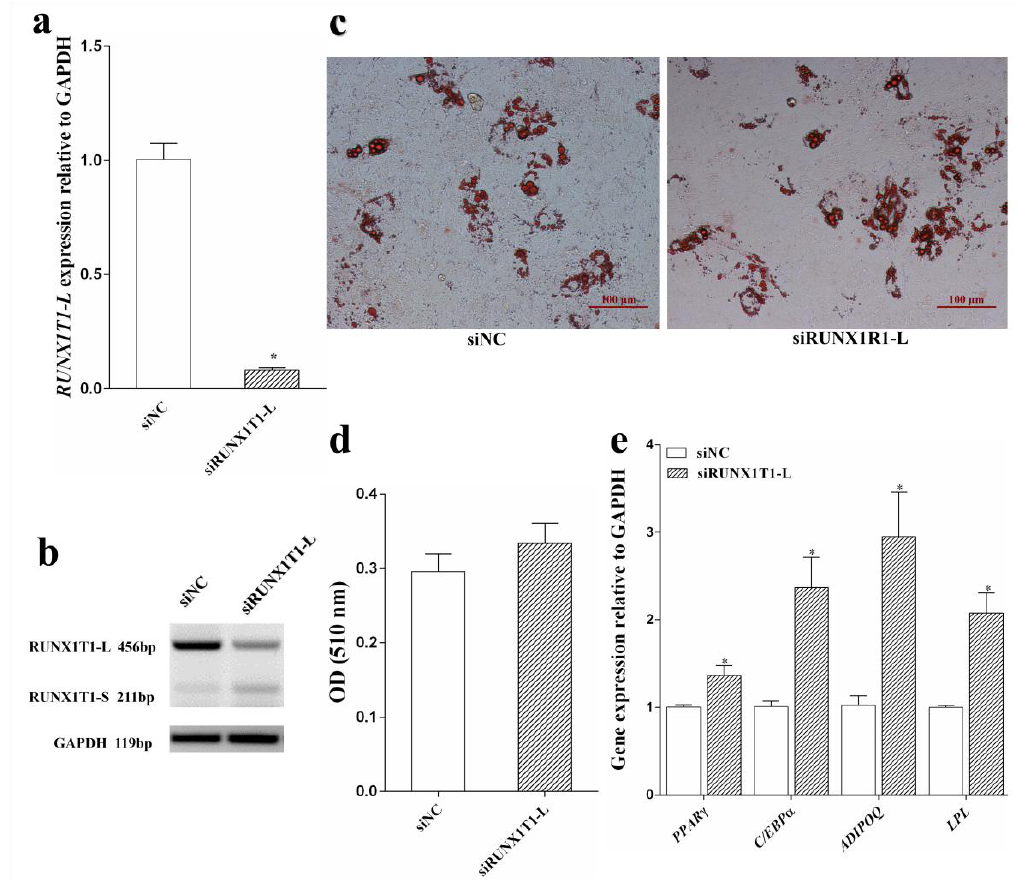
Figure 7. Adipogenic differentiation of ovine preadipocytes with RUNX1T1-L knockdown. siRUNX1T1-L and siNC were introduced into ovine preadipocytes when the density reached about 70%, and 48 h later, cells were subject to adipogenic differentiation ( a ). The expression of RUNX1T1-L was determined at 48 h post-transfection by Real-time PCR. Moreover, the expression of RUNX1T1-S was analyzed by semi-qRT-PCR ( b ). Ovine preadpocytes were transfected with siRUNX1T1-L or siNC and differentiated into mature adipocytes ( c ). Scale bars = 100 µm. After 8 days of differentiation, intracellular lipid droplets were stained using Oil Red-O. Lipid content was indirectly determined by measuring the optical density (OD) value at 510 nm on a spectrophotometer ( d ). Real-time PCR was performed on day 6 of adipogenic differentiation to determine the mRNA level of maker genes ( e ). Independent Students’ t -test. * p < 0.05 against siNC. Quantitative data are represented as the mean ± SEM ( n = 4).